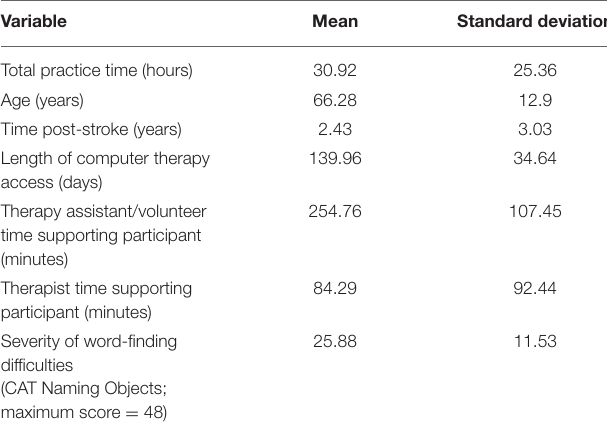
TABLE 2 | Descriptive summary table of key